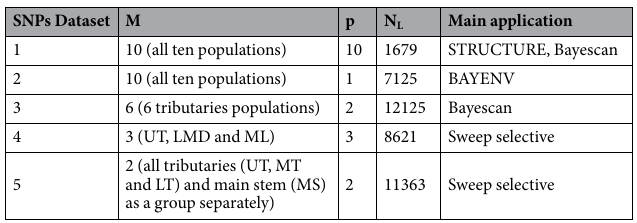
Table 2. 6 SNPs datasets constructed by the populations programs of STACKS. M and P are two main parameters of populations , M is the population map that determine which groupings to use for calculating summary statistics, p determines the minimum number of populations a locus must be present in to process a locus. N L is the number of SNP loci in SNPs dataset, main application is the software that the dataset would be